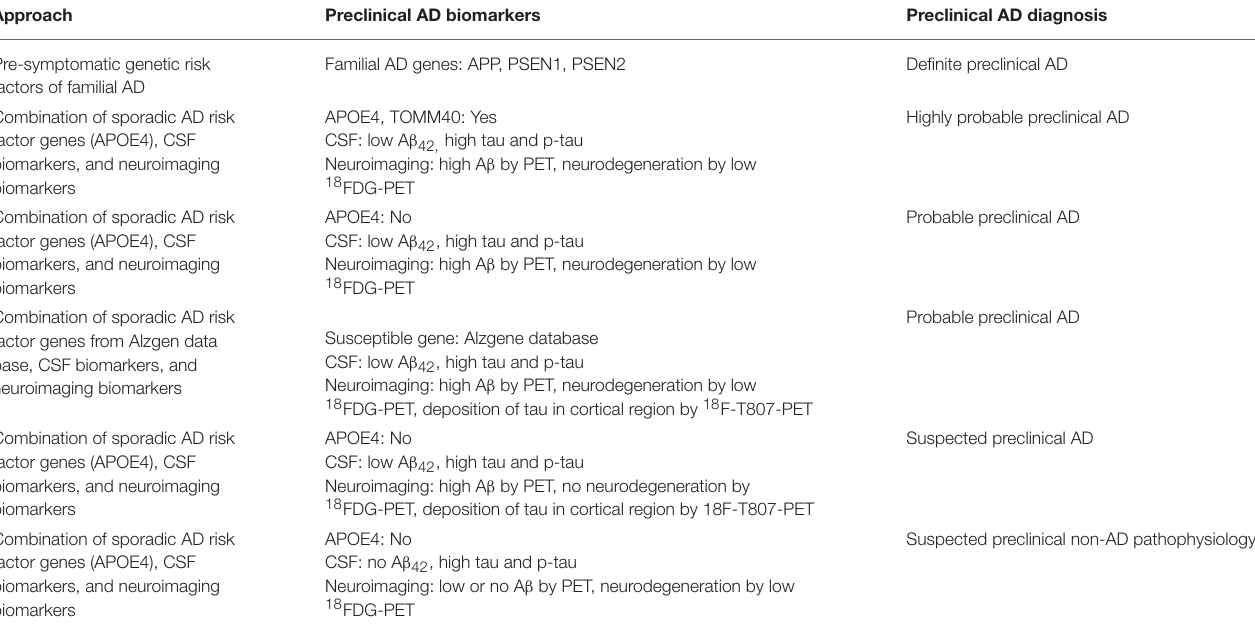
TABLE 4 | Algorithm for preclinical Alzheimer’s disease